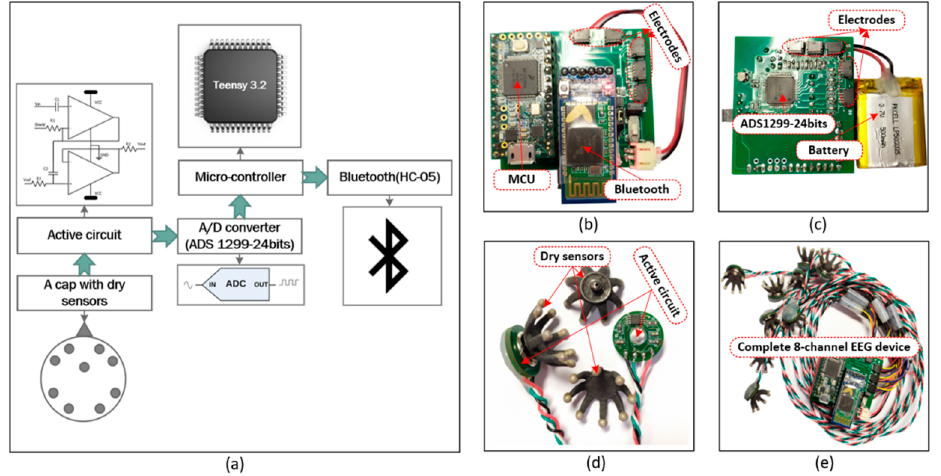
Figure 1. ( a ) Block diagram of the proposed EEG device; ( b ) top view of the EEG device; ( c ) bottom view of the EEG device; ( d ) dry sensors and active circuits; ( e ) complete 8-channel EEG device.